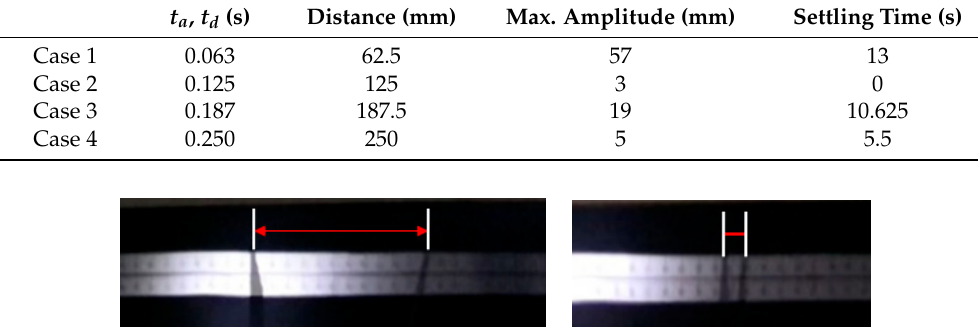
Figure 21. The velocity profiles when moving a short distance with a maximum velocity of 1000 mm/s. Table 6. Experimental results of maximum amplitude and settling time when moving a short distance with a maximum velocity of 1000 mm/s.